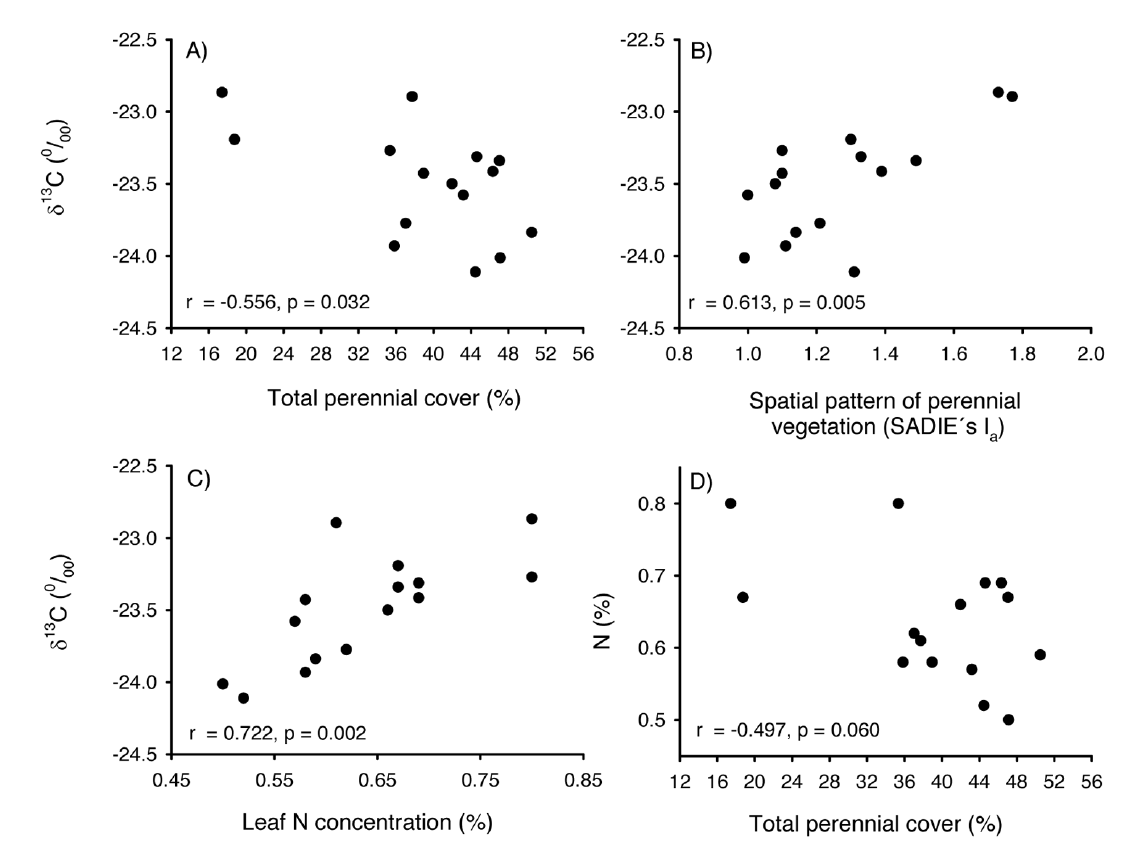
Fig. 2. Relationships between the δ 13 C of Stipa tenacissima and total perennial plant cover (A), the spatial pattern of perennial vegetation (B) and leaf N content (C), and between total plant cover and leaf N content (D). Plant spatial patterns were measured using SADIE analysis (Perry et al. 1999), in 15 steppes from SE Spain. As I increases, the spatial pattern of vegetation becomes more aggregated. a Results of correlation analyses (Pearson correlation coefficient) are also shown. Adapted from data presented in Maestre and Cortina